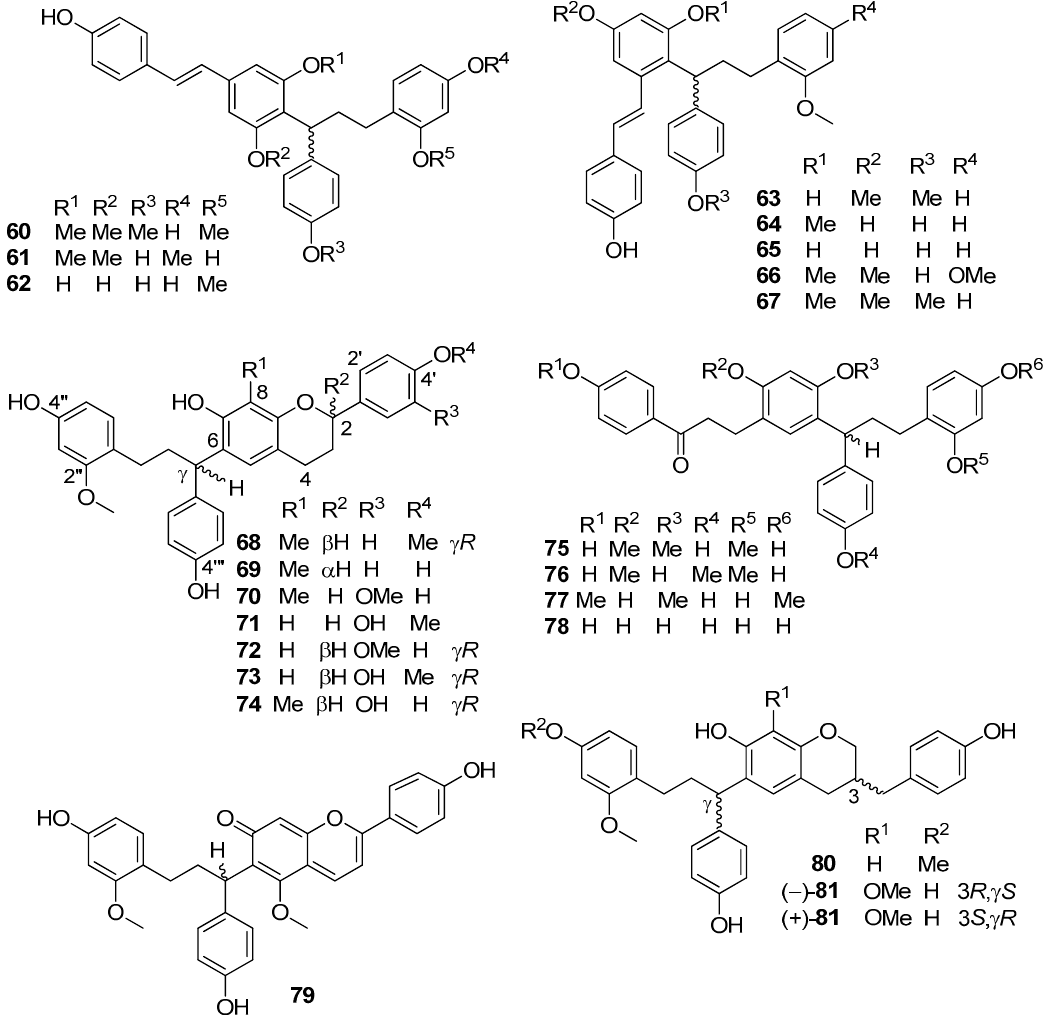
Figure 12. Selected flavonoid dimers from D. cochinchinensis red resin.